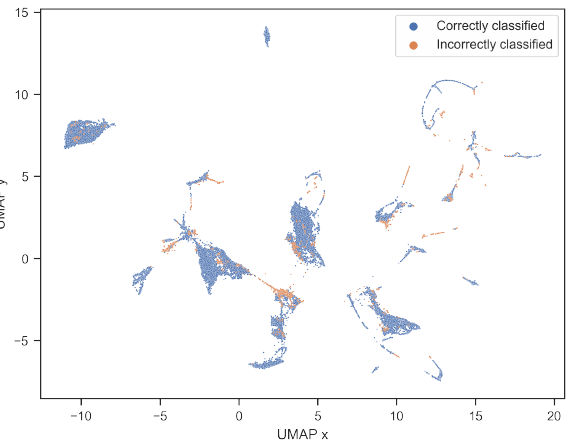
Figure 6. Samples correctly and incorrectly classified using the RF obtained in the last iteration.